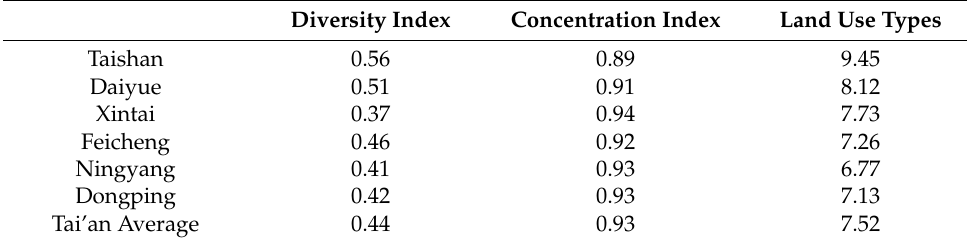
Table 3. Description of rural construction land